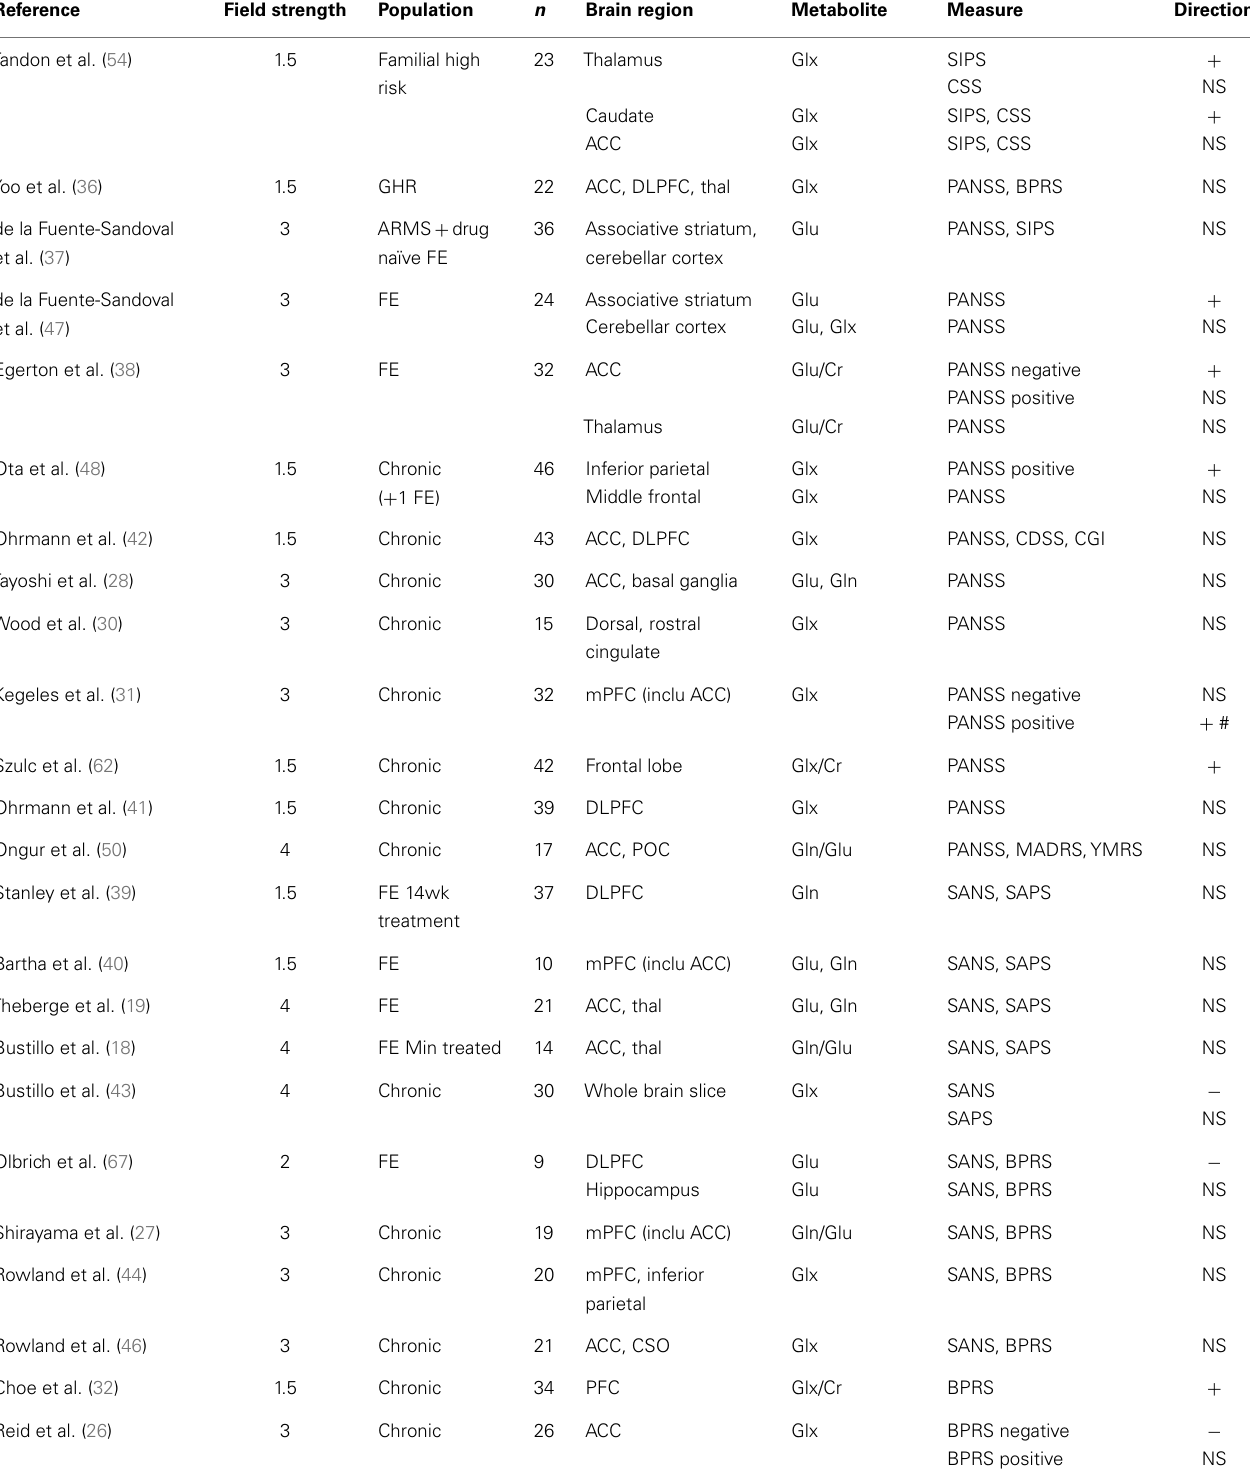
Table 1 | Summary of articles reporting high levels of glutamate metabolites associated with greater or lesser severity of